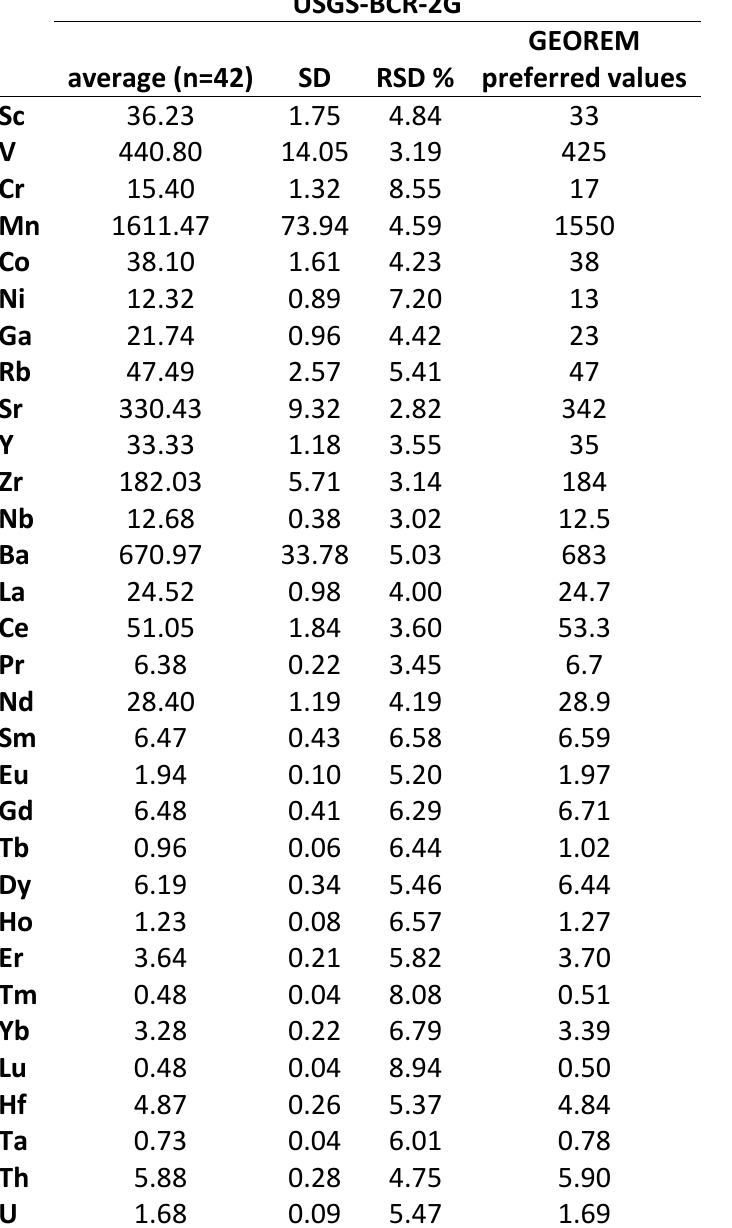
Table 1: Reproducibility and accuracy of the LA-ICP-MS analyses. Abbreviations: SD - standard deviation, RSD - relative standard deviation. GEOREM preferred values from Jochum et al .